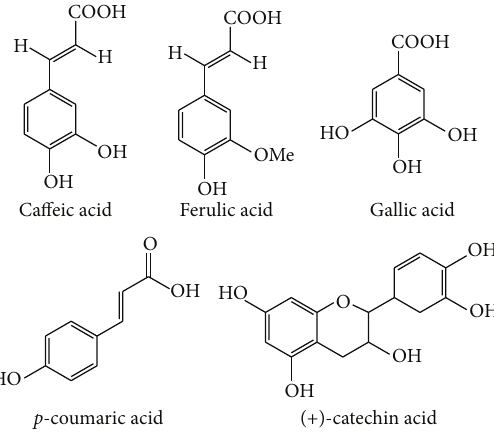
Figure 2: Different phenolic compounds isolated from M. charan- tia